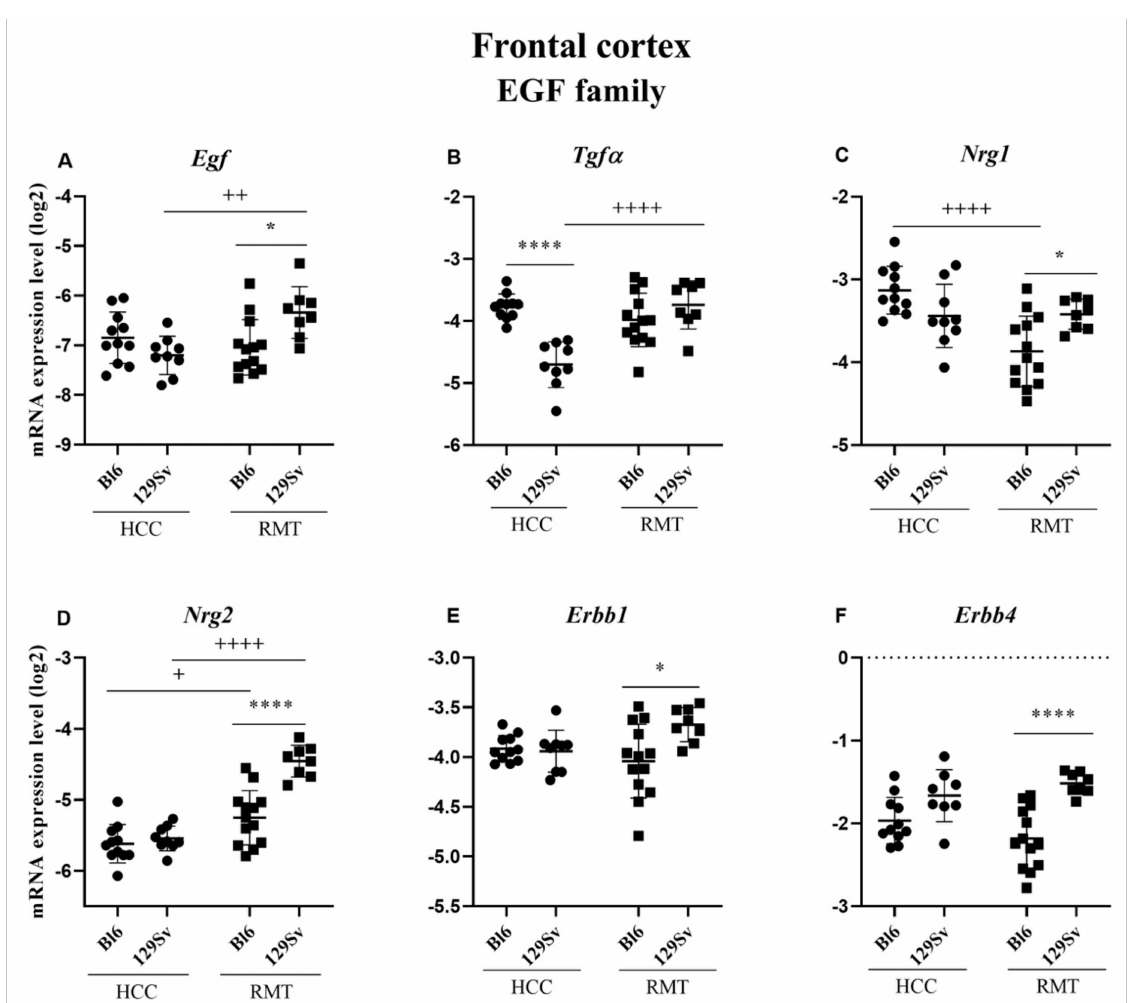
Figure 10. Egf family gene expression in the frontal cortex of Bl6 and 129Sv mice. Two-way ANOVA was applied to demonstrate differences between the strains and environments. Substantial statistically significant gene expressions for ( A ) Egf —epidermal growth factor, ( B ) Tgfa —transforming growth factor alpha, ( C ) Nrg1 —neuregulin 1, ( D ) Nrg2 —neuregulin 2, ( E ) Erbb1 —epidermal growth factor receptor and ( F ) Erbb4 —Erb–b2 receptor tyrosine kinase 4. Bonferroni post hoc test: * p ≤ 0.05 and **** p ≤ 0.0001 compared to respective 129Sv mice, + p ≤ 0.05, ++ p ≤ 0.01 and ++++ p ≤ 0.0001 in strain specific comparison. Data are expressed as mean values ± SD. Number of animals in each group varied from 8 to